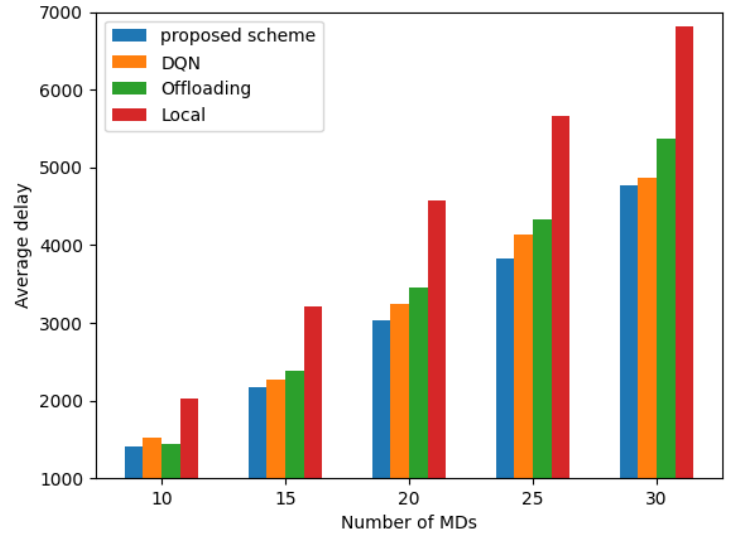
Figure 5. Average delay evaluation with different number of MDs.